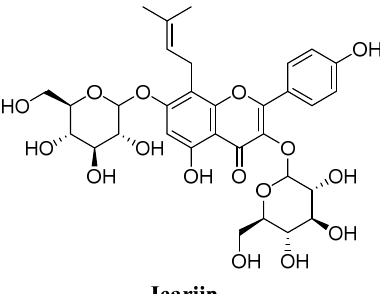
Figure 17. Icariin. Figure 17.